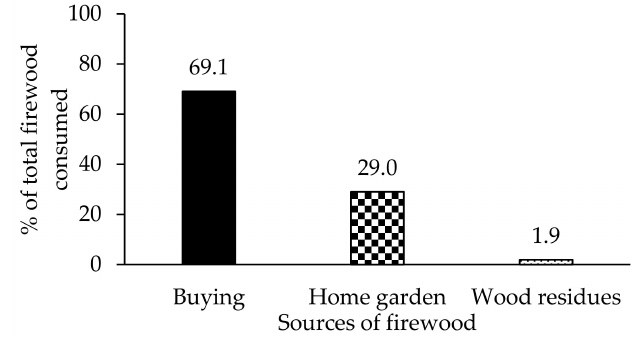
Figure 2. Sources of firewood consumed in urban area of Yedashe